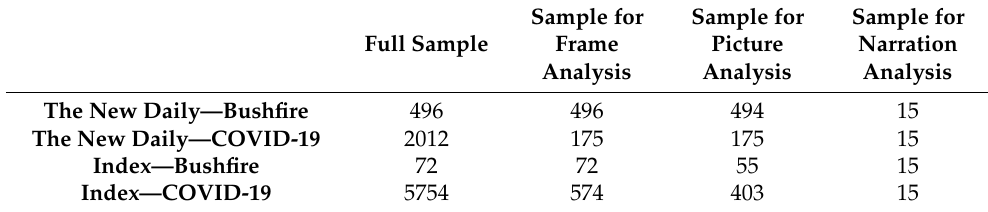
Table 1. Number of articles at the different levels of analysis.